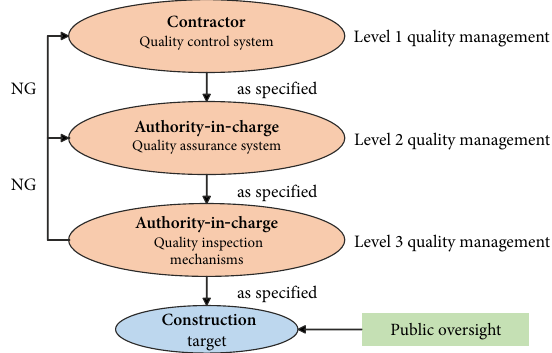
Figure 1. Framework of three-level quality management